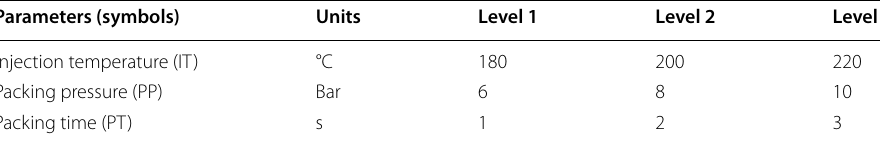
Table 1 Injection moulding process parameters and their level selection Parameters (symbols)